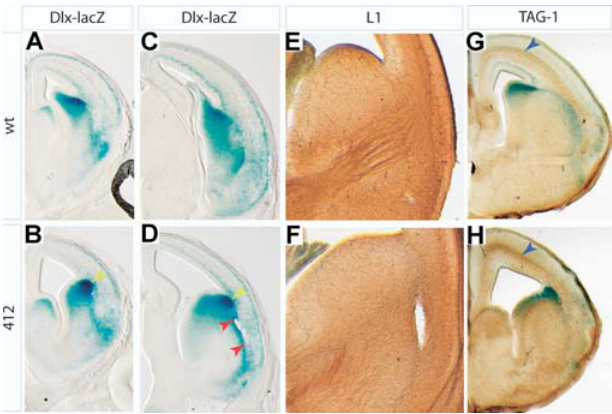
Figure 7. Corticostriatal Delamination and Lack of the Thalamocortical Projection in Line 412 Mutants (A–D) Coronal hemisections of E15.5 WT (A and C) and line 412 (B and D) mutant embryos stained for the Dlx-LacZ transgene. The cortex is thinner in 412 mutants, as can be seen in both the rostral (B) and the caudal (D) sections. Delamination of the corticostriatal boundary can be seen in the region between the red arrowheads in (D). (E and F) Immunostaining for L1 antigen labels the thalamocortical fibers in coronal hemisections from E14.5 WT (E) and mutant (F) embryos. The striatum and corticostriatal areas are shown. In the WT section, the thalamocortical fibers can be seen traversing the striatum through the internal capsule and coursing into the cortex. In the mutant section, a few fibers enter the striatum but do not traverse it to reach the cortex. Corticostriatal delamination can be seen as a hole in the right side of the section. (G and H) Immunostaining for TAG1 antigen (blue arrowheads) reveals corticofugal